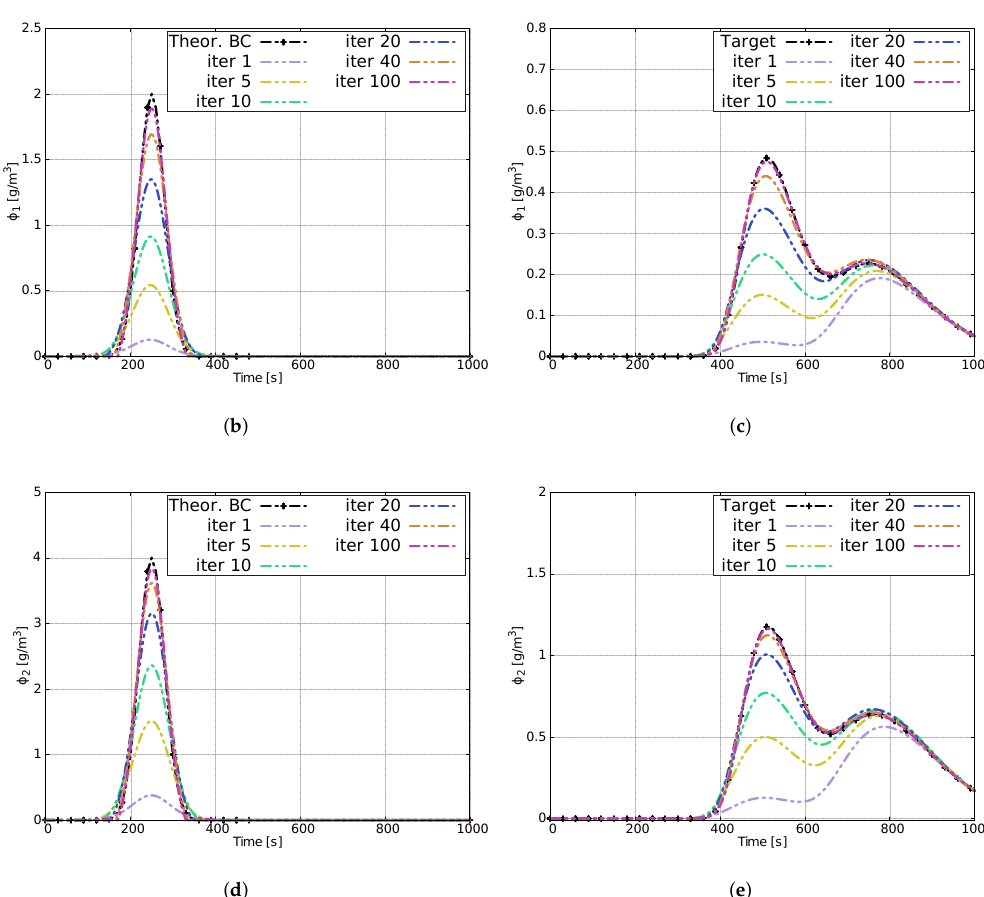
Figure 11. Case 4. Temporal evolution of flow-rate at x M ,2 = 35.5 m ( a ) and reconstruction of the boundary condition φ 1 and φ 2 ( b , d ) and target at x M ,2 = 35.5 m ( c , e